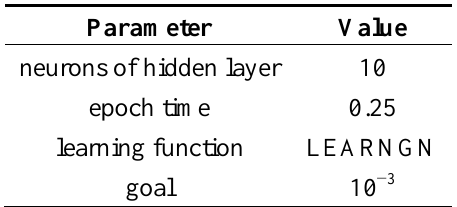
Table 4. The parameters setting of BP method.